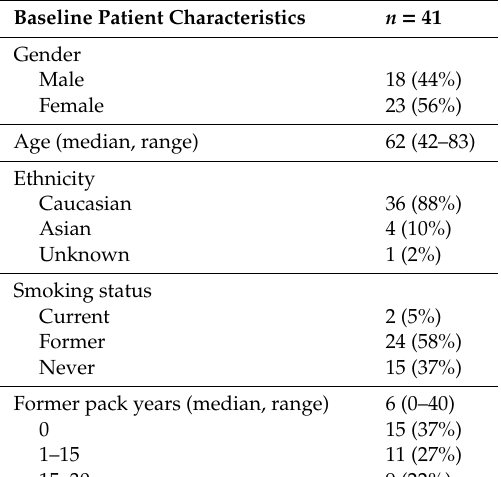
Table 1. Baseline